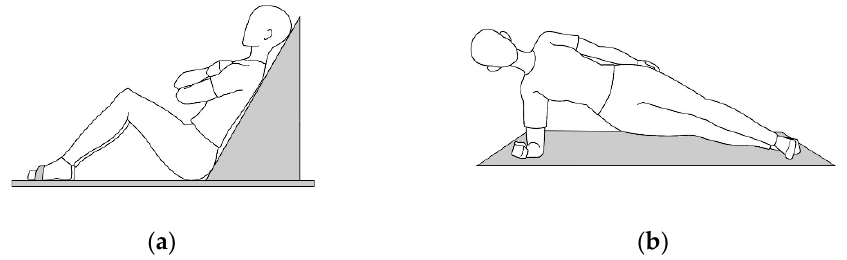
Figure 2. Static trunk endurance test: ( a ) Trunk flexor endurance test; ( b ) Bilateral side bridge test.